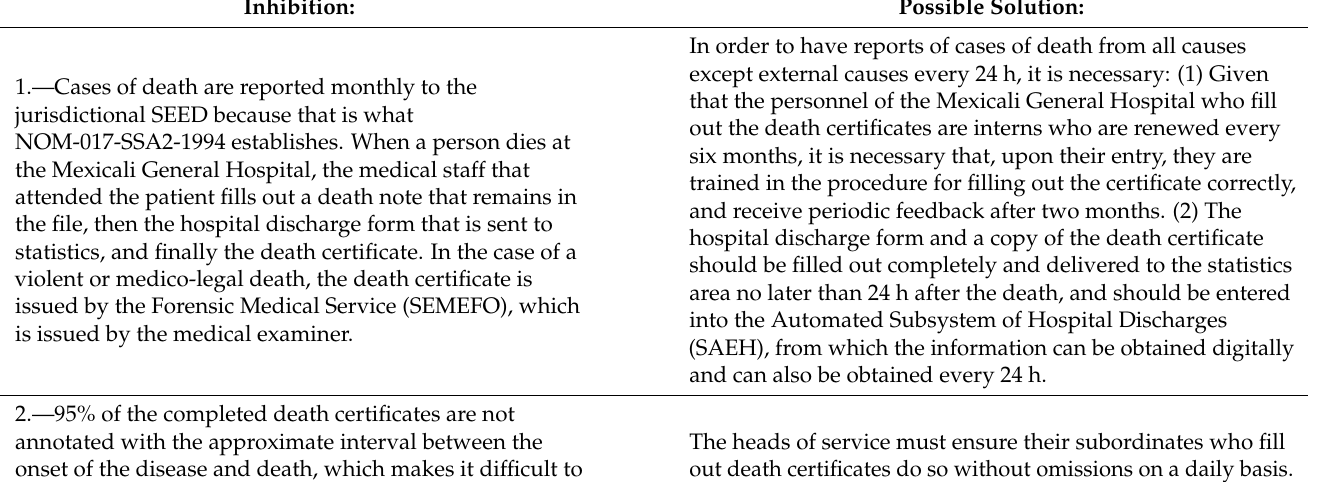
Table 4. Inhibitions and solutions for the daily recording of mortality data for all but external causes in Mexicali B.C.